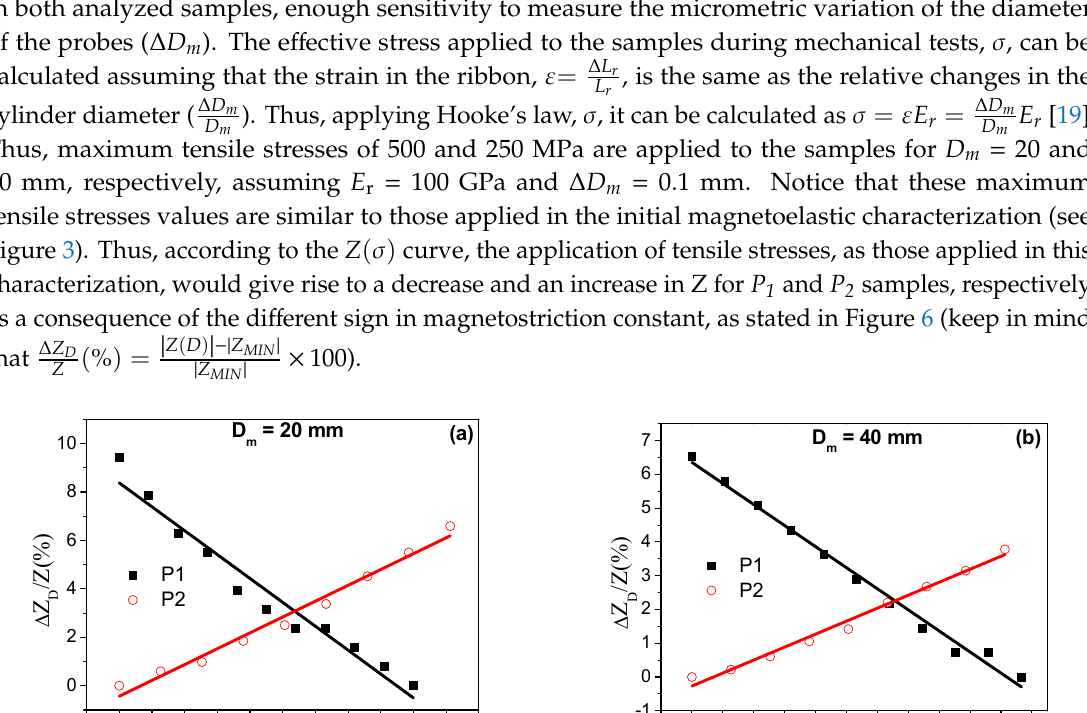
Figure 6. Relative variations of impedance, in probe diameter, ∆D m , for D m ( a ) 20 mm and ( b ) 40 mm.